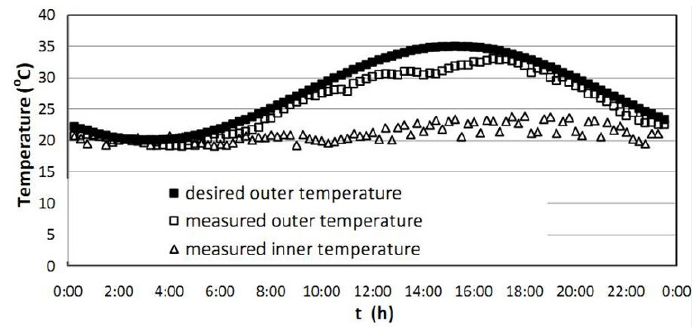
Figure 16. Temperature at the inner and outer side and desired temperature at the outer side. Scenario 3